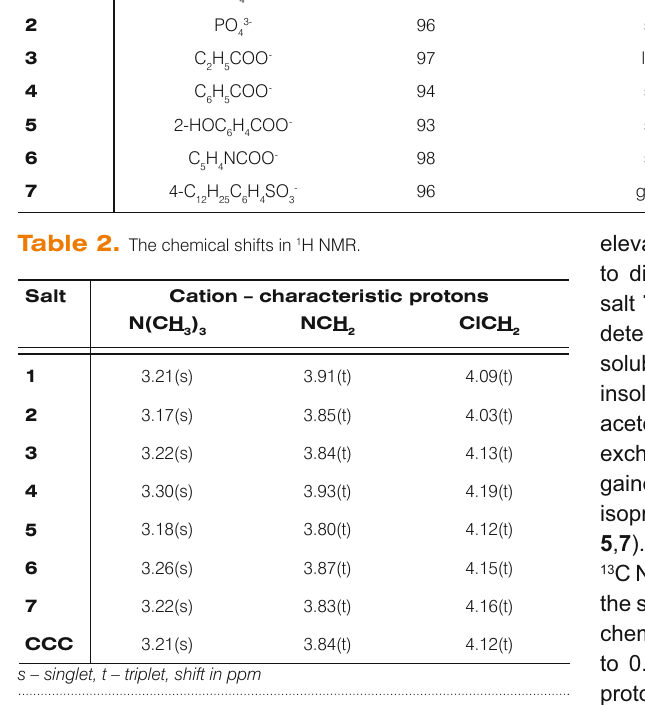
Table 3. Thermal properties of CCC